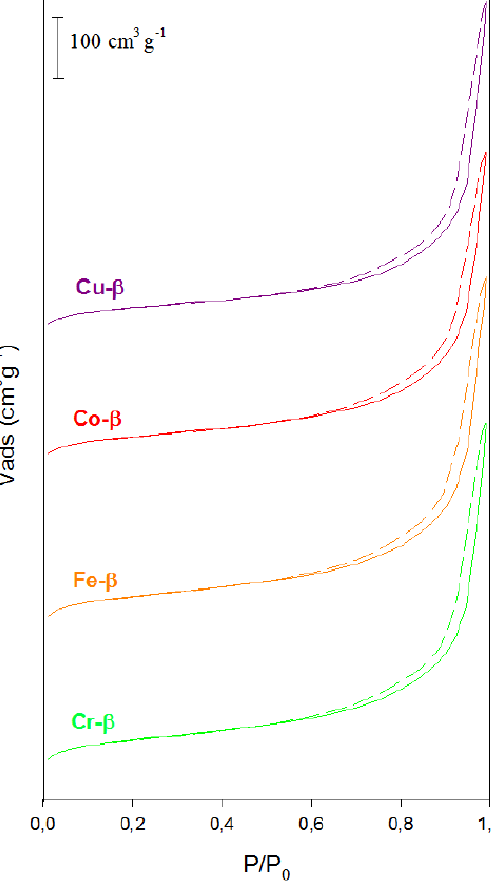
Figure 2. Representative N adsorption-desorption isotherms for metal exchanged β 2